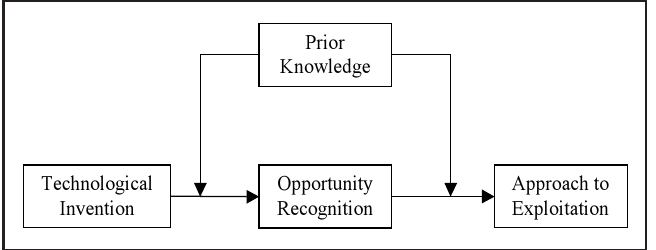
Figure 1. Shane’s (2000) Conceptual